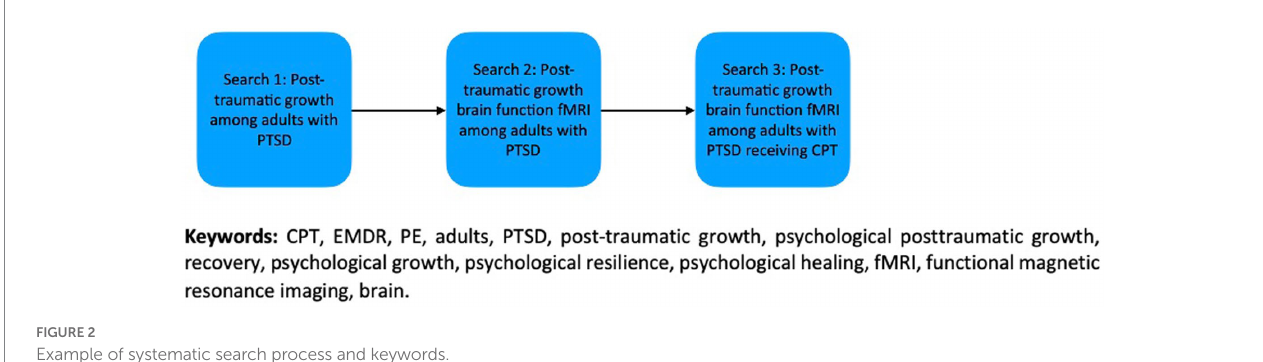
FIGURE 2 Example of systematic search process and